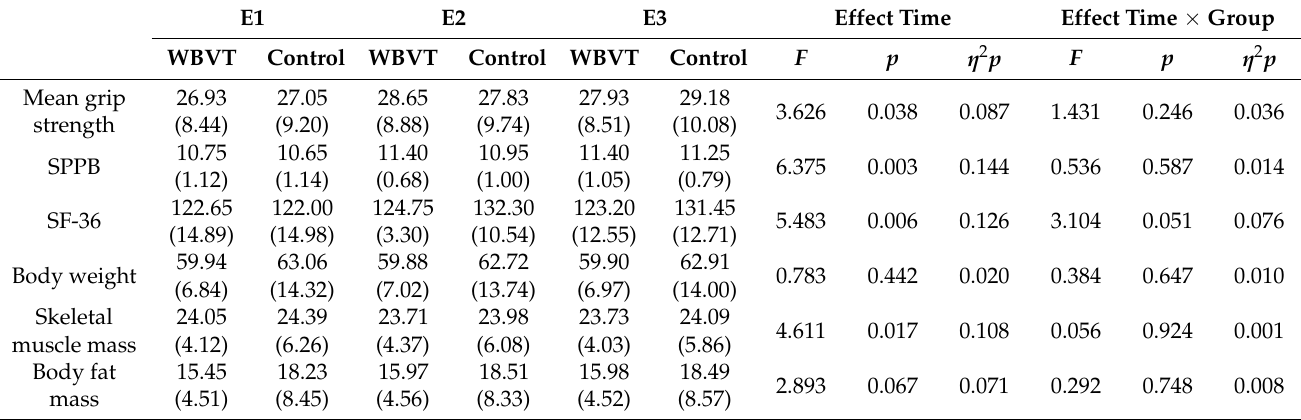
Table 4. Secondary outcome measures (grip strength, SPPB, SF-36 and Body composition analysis).